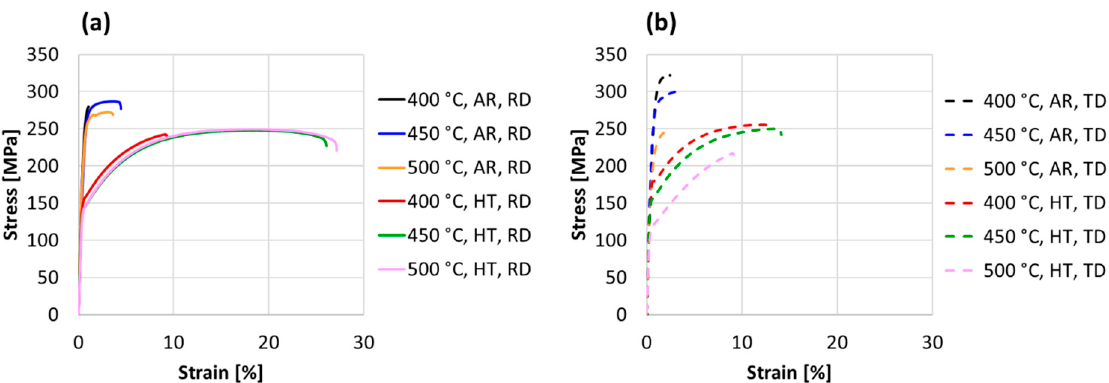
Figure 3. Engineering stress–strain diagram in ( a ) RD and ( b ) TD from the sheets in as-rolled (AR) and heat-treated (HT) condition. Table 1. Tensile properties at room temperature of the as-rolled sheets tested along RD, TD (TYS, tensile 0.2% yield stress; UTS, ultimate tensile stress, ε u , uniform elongation; ε f , elongation to fracture).